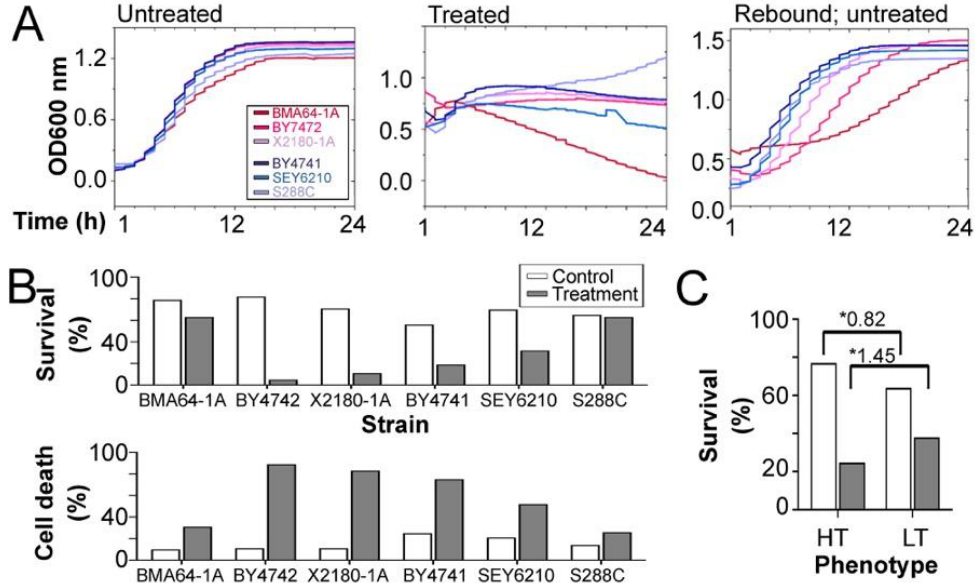
Figure 2. Cell growth and flow cytometry assays were used to evaluate EtOH stress severity. ( A ) Growth curve analyses of the populations of untreated cells, cells treated with the highest EtOH level previously defined, and the population rebound experiments (growth curves of the populations of cells inoculated in pure YPD medium after 1 h of treatment with the highest tolerated EtOH level). ( B ) Percentages of live and dead cells of each strain under control and treatment conditions. ( C ) Percentages of live cells of each phenotype under control and treatment conditions. The numbers above the bars are the “rate” comparing the average of the LT strains divided by the average of the HT strains. Hence, a rate > 1 indicates more live cells of the LT strains. *: Rate between LT divided by